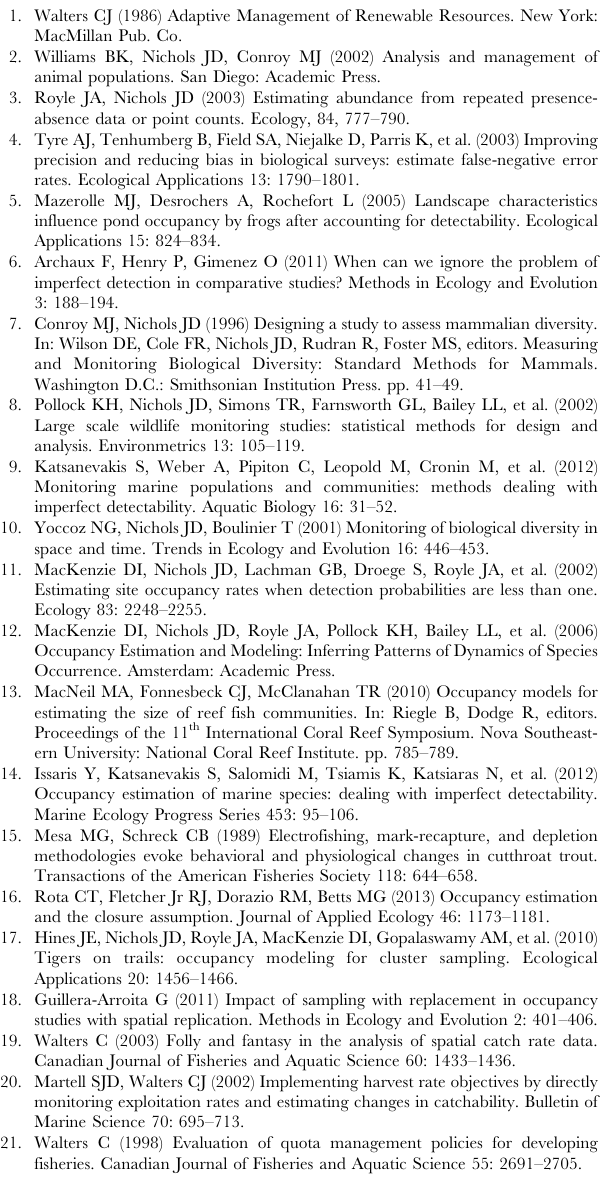
Table S1 Data analyzed in this study. Note that the first two columns contain the numbers of red snapper detections (det) from the chevron and camera traps. Refer to Table 1 for a description of the covariate